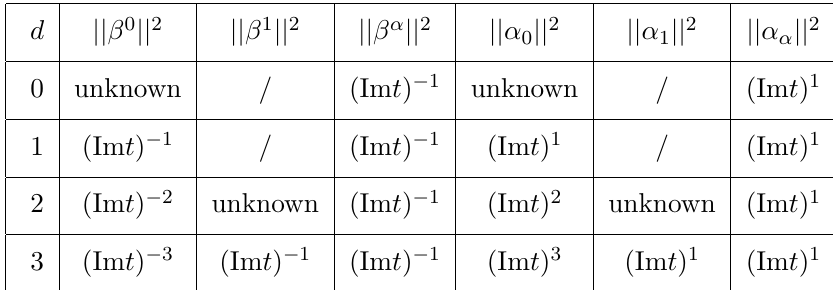
are de(cid:12)ned to obey (2.5). K